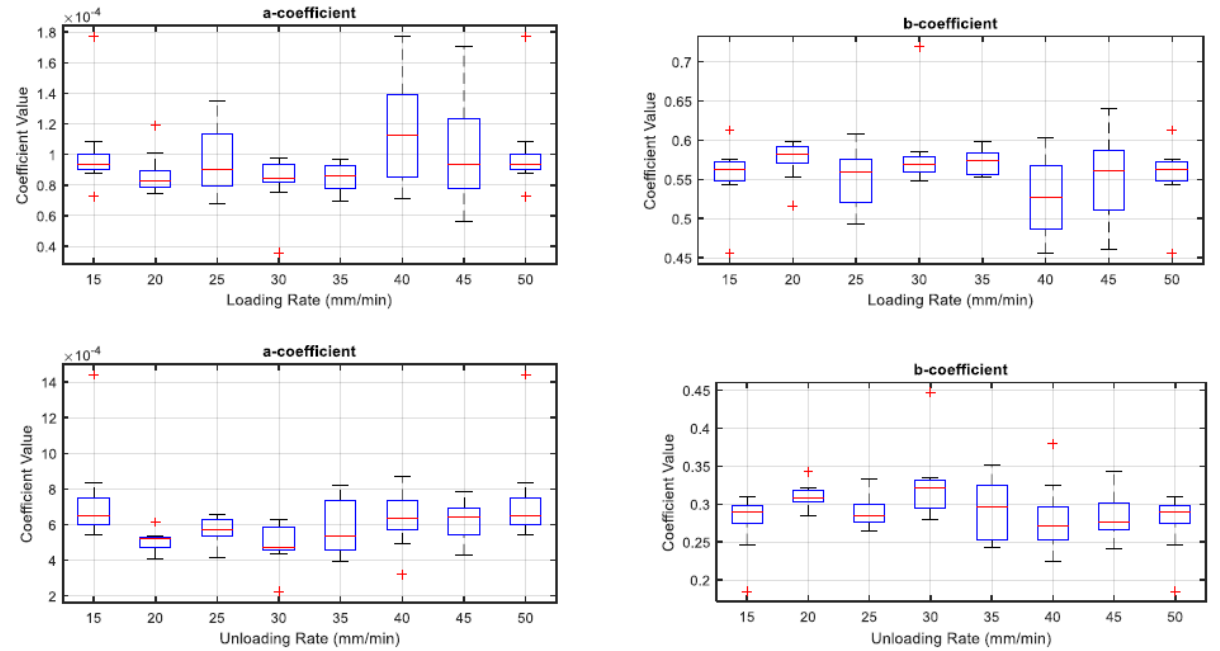
Figure 21. Box Plots for coefficient variability of Equation (3).